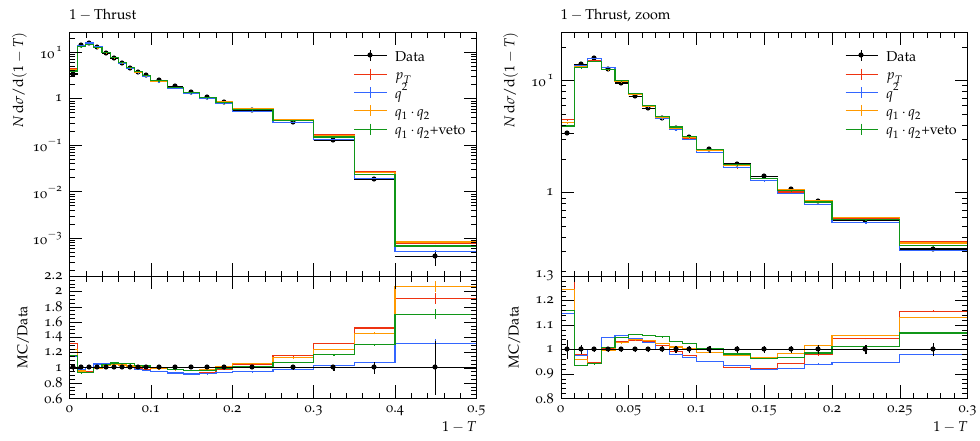
Figure 4 . The thrust at the Z-pole compared with data from the DELPHI [44] experiment. In the right panel a zoom for small 1 T values is shown. (cid:0)